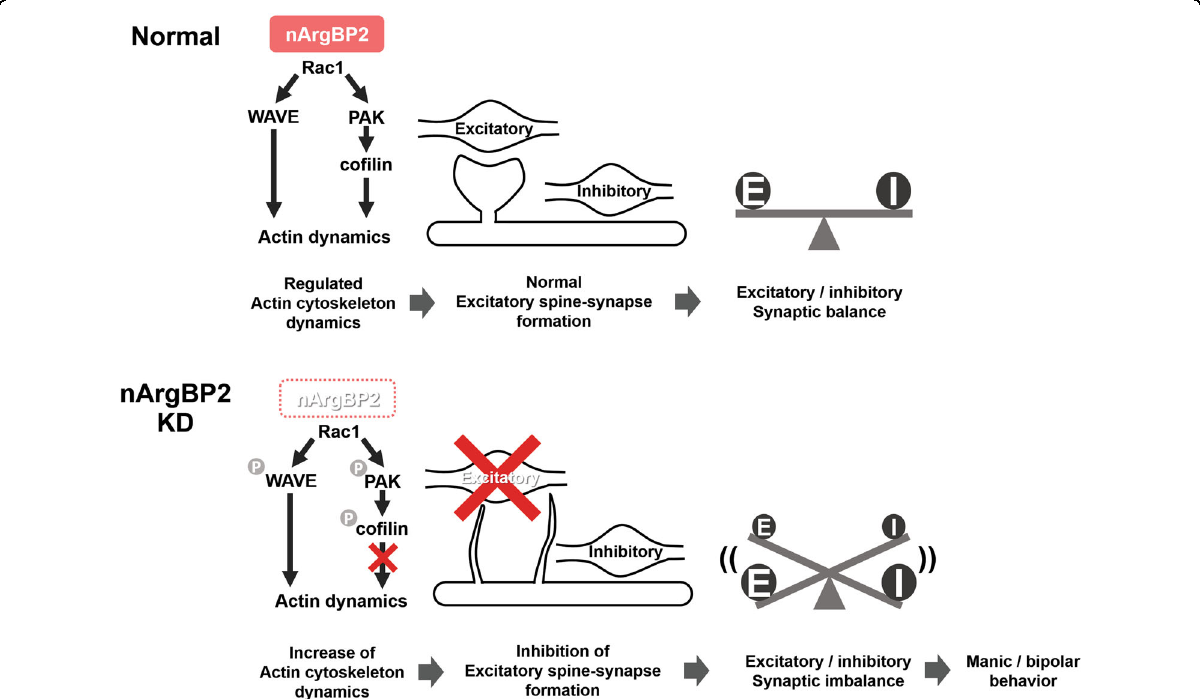
Fig. 2 Schematic description of the role of nArgBP2 in excitatory spine-synapse formation and maintenance of E/I balance. In the normal condition, nArgBP2 plays a role in controlling actin cytoskeleton dynamics through the WAVE and PAK/co fi lin cascade. Its ablation, however, increases actin dynamics via uncontrolled phosphorylation of the WAVE/PAK/co fi lin pathway, causing a robust and selective inhibition of excitatory spine-synapse formation. This subsequently leads to an excitatory/inhibitory synaptic imbalance. Since the excitatory/inhibitory synaptic imbalance likely leads to a broad spectrum of psychiatric disorders, nArgBP2 KD, which selectively alters excitatory synapse formation, may account for the manic/bipolar-like behaviors observed in nArgBP2 KO